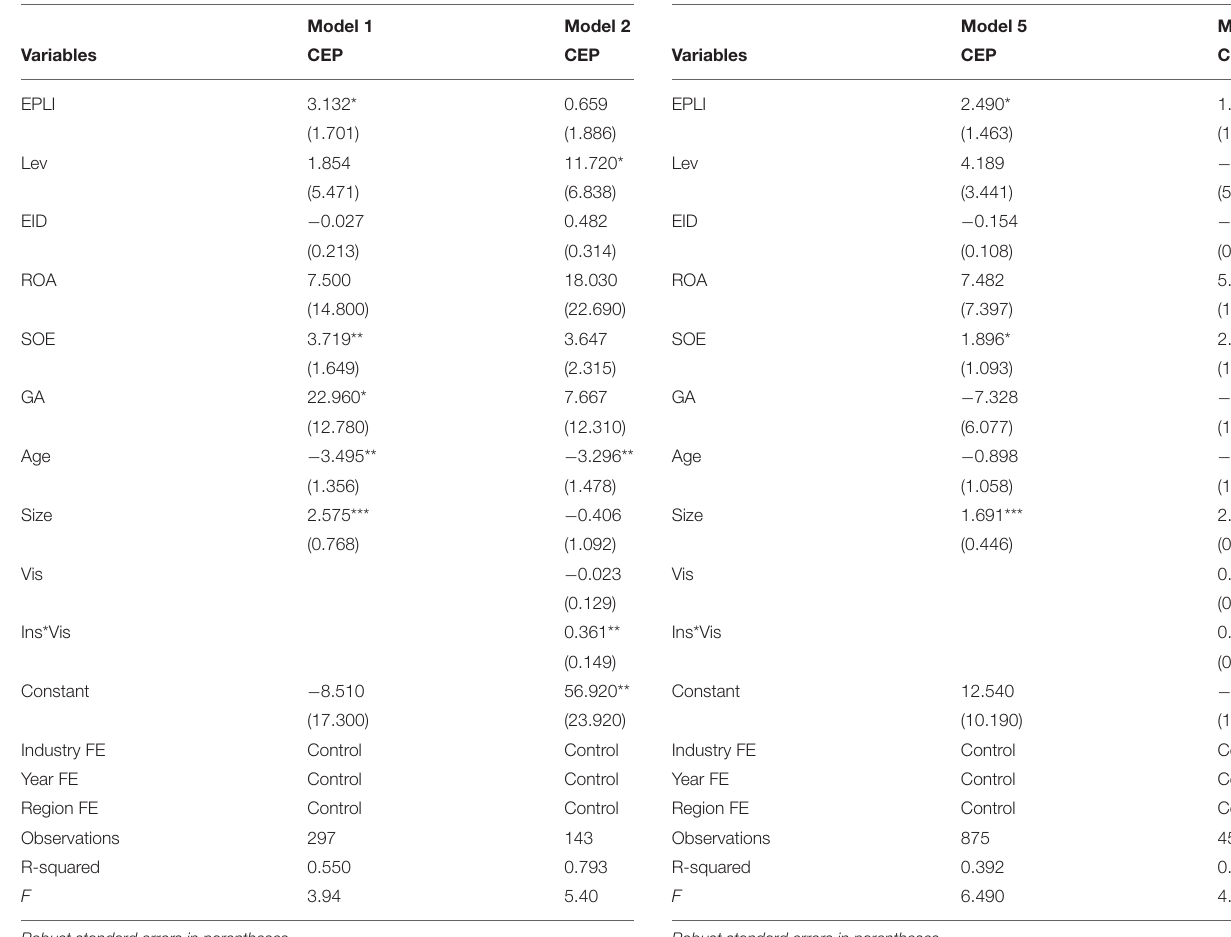
TABLE 7 | Robustness test (1). TABLE 8 | Robustness test